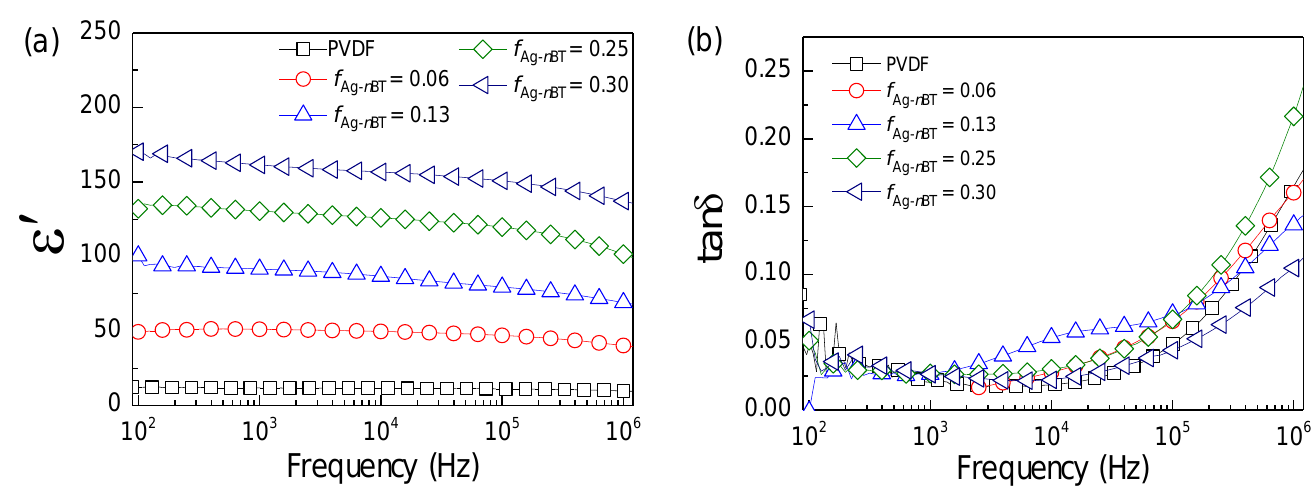
Figure 7. Frequency dependence on ( a ) ε′ and ( b ) tanδ of the Ag- n BT/PVDF-(0.2) μ BT composites with various f Ag-nBT .